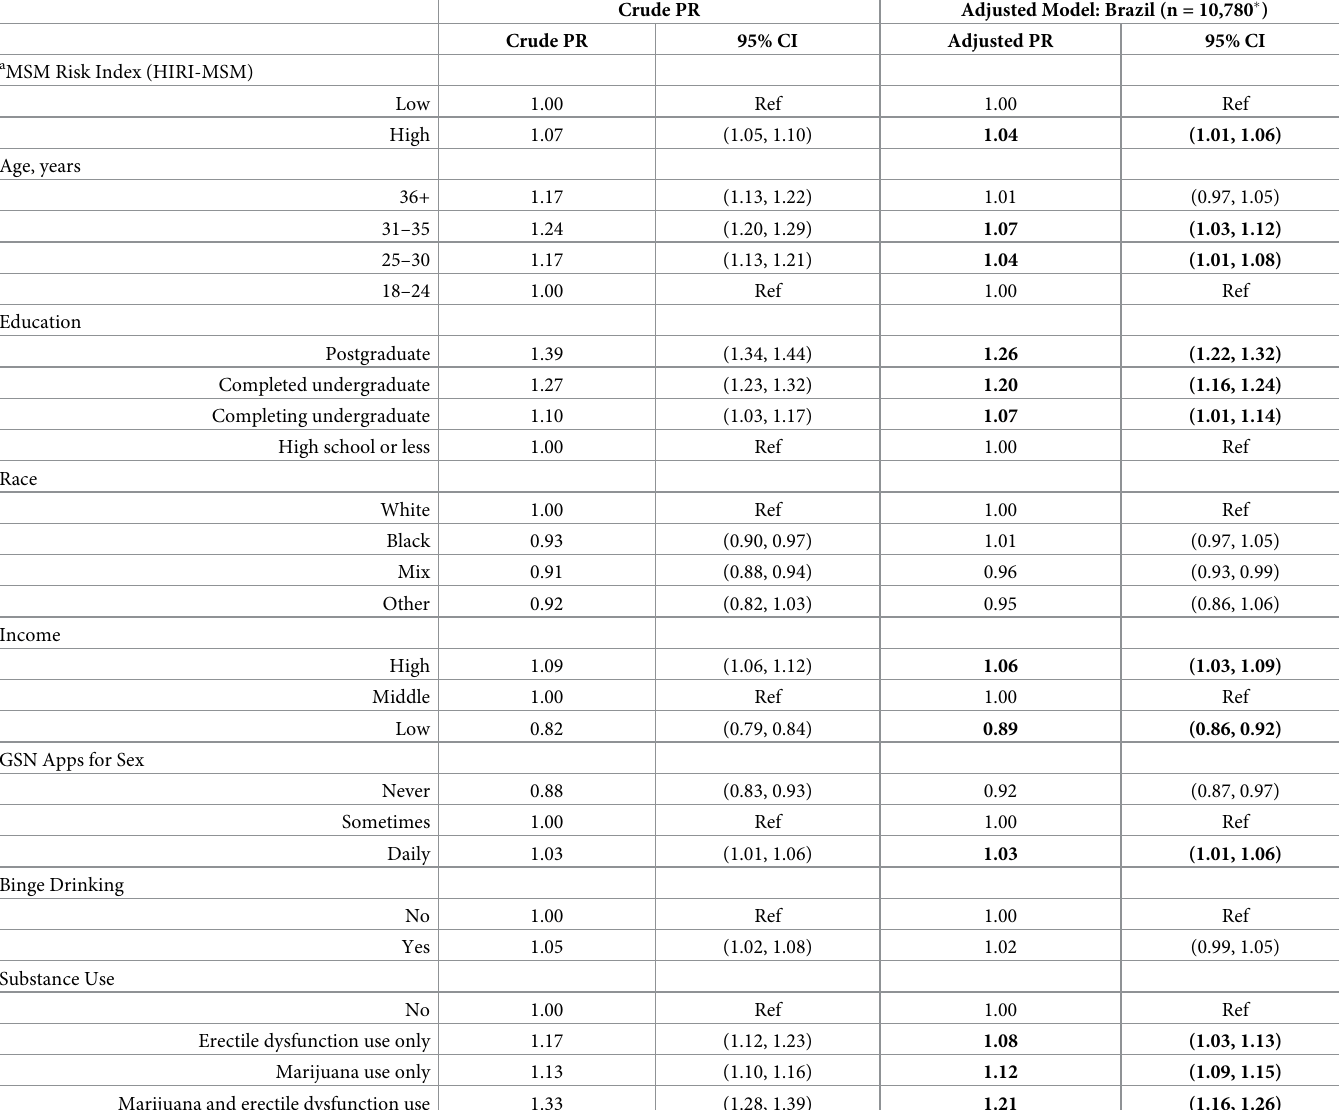
Table 2. PrEP awareness among MSM in Brazil, crude and adjusted prevalence ratios (n = 11,325) April,